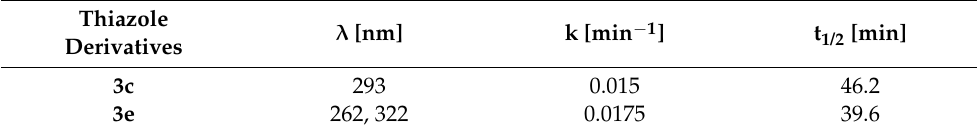
Figure 6. Effect of compounds 3c and 3e on cell cycle distribution in A549 cells. After the treatment with the indicated concentrations of compounds 3c and 3e for 48 h, the cells were stained with propidium iodide and analyzed by flow cytometry. ( A ) Representative DNA histograms of A549 cells treated with compounds 3c and 3e . ( B , C ) Statistical analysis of the percentages of A549 cells in the sub-G1, G0/G1, S, and G2/M phases after treatment with compounds 3c and 3e , respectively. Data are expressed as means ± SD from three independent experiments. ** p < 0.01 and *** p < 0.001 in comparison to the control; one-way ANOVA followed by Tukey’s post hoc test. Table 5. Half-life (t1/2) for the spontaneous hydrolysis of selected compounds 3c and 3e